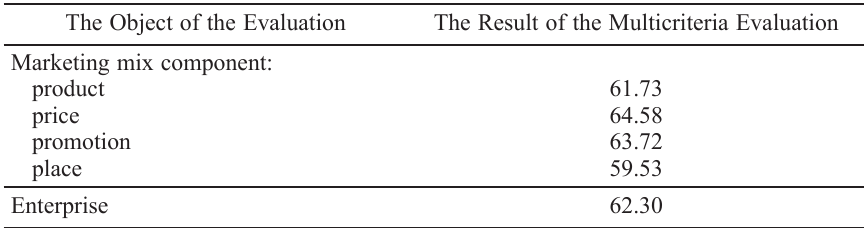
Table 3. The result of the multicriteria evaluation of marketing activity of an enterprise The Object of the Evaluation The Result of the Multicriteria